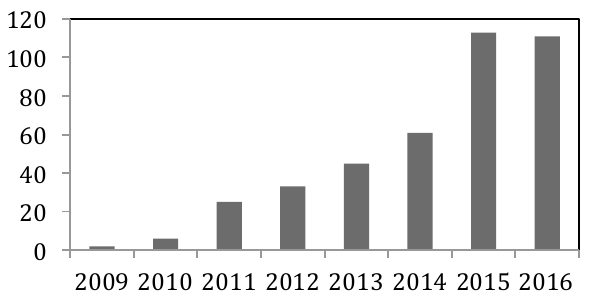
Fig. 3. Number of Arduino-related publications per